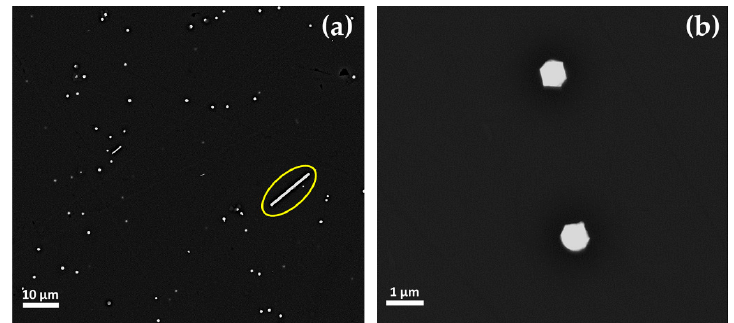
Figure 14. FEG–SEM micrographs of sample R10 (Gr-2 group). ( a ) Different dimensions of the copper-